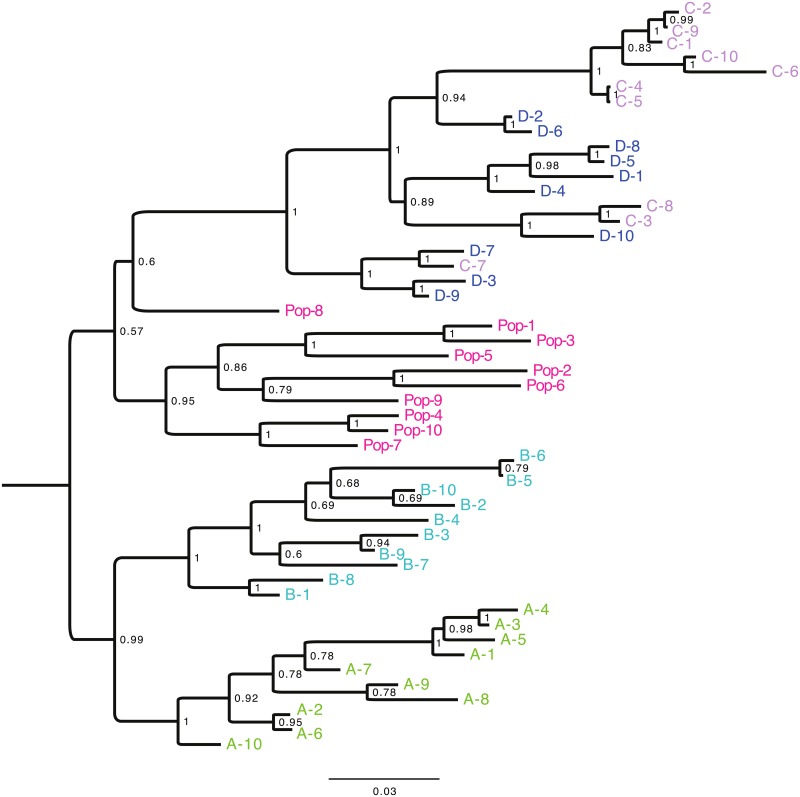
Phylogenetic relationships between Aedes aegypti isofemale lines.Bayesian phylogenetic tree representing the genetic diversity across individuals from the four isofemale lines (A, B, C and D) and from a field-derived outbred population (Pop) from the same geographic location where the lines were created. The phylogenetic analysis was based on a GTR+G substitution model of 2,321 SNPs. Putative populations are depicted in different colors. The scale bar indicates the number of substitutions and posterior probabilities are displayed at relevant nodes.